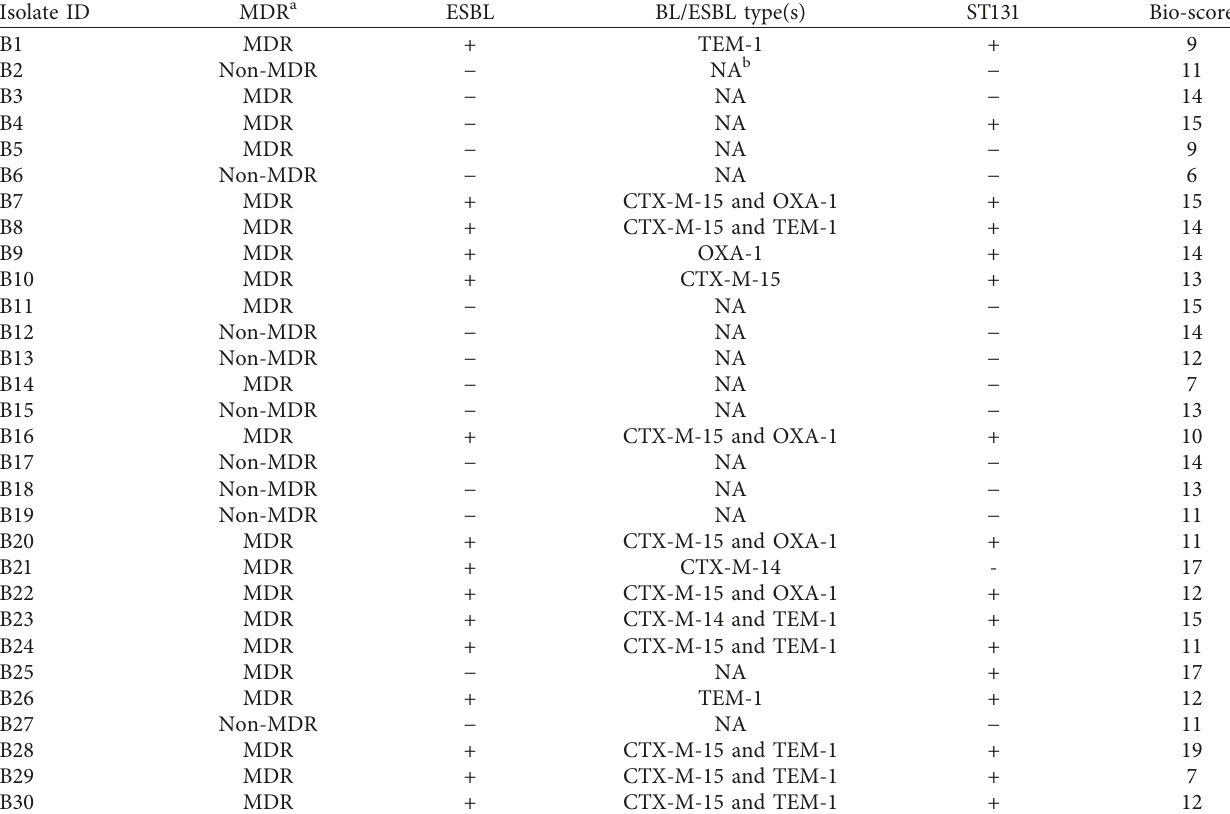
Table 5: Relating the antibiotic susceptibility profiles to the biochemical activity of all isolates. Isolate